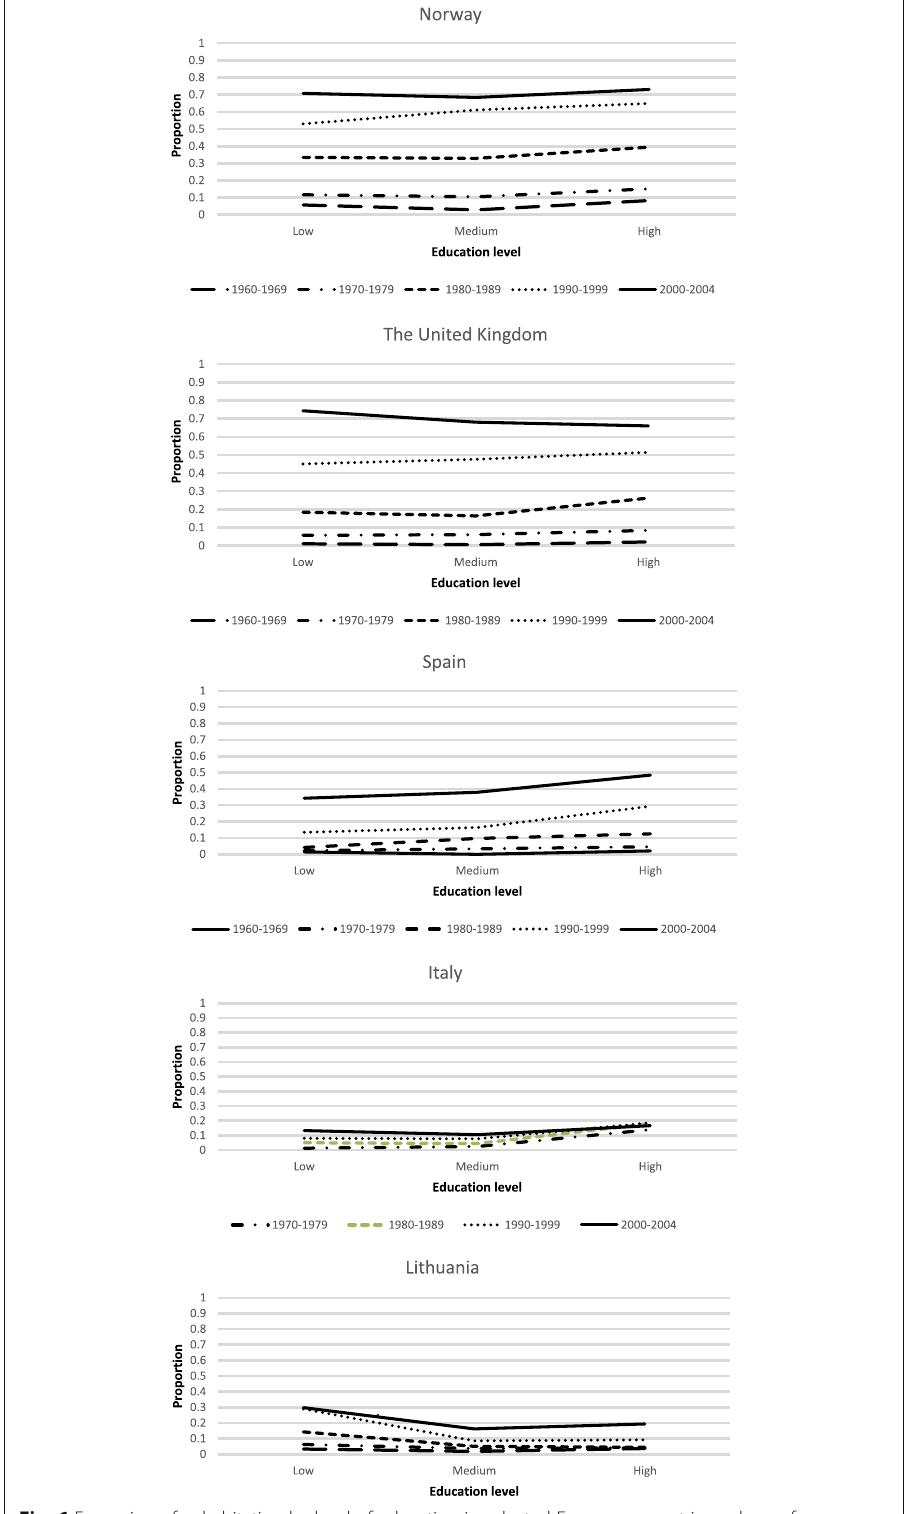
Fig. 6 Expansion of cohabitation by level of education in selected European countries — share of cohabitation for at least 1 year relative to all women 25 – 29 who were in a union (married + cohabiting) for at least 1 year. Source: Courtesy of Jorik Vergauwen, Antwerp University. Data: Gender and Generation Survey harmonised data and national